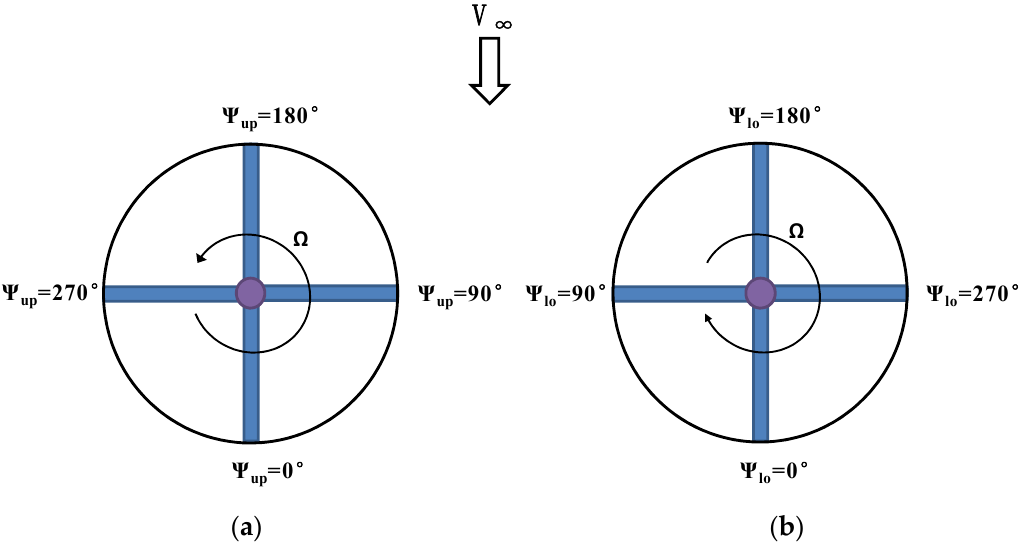
Figure 5. Definition of the azimuthal rotor blade position. ( a ) Upper rotor; ( b ) lower rotor.